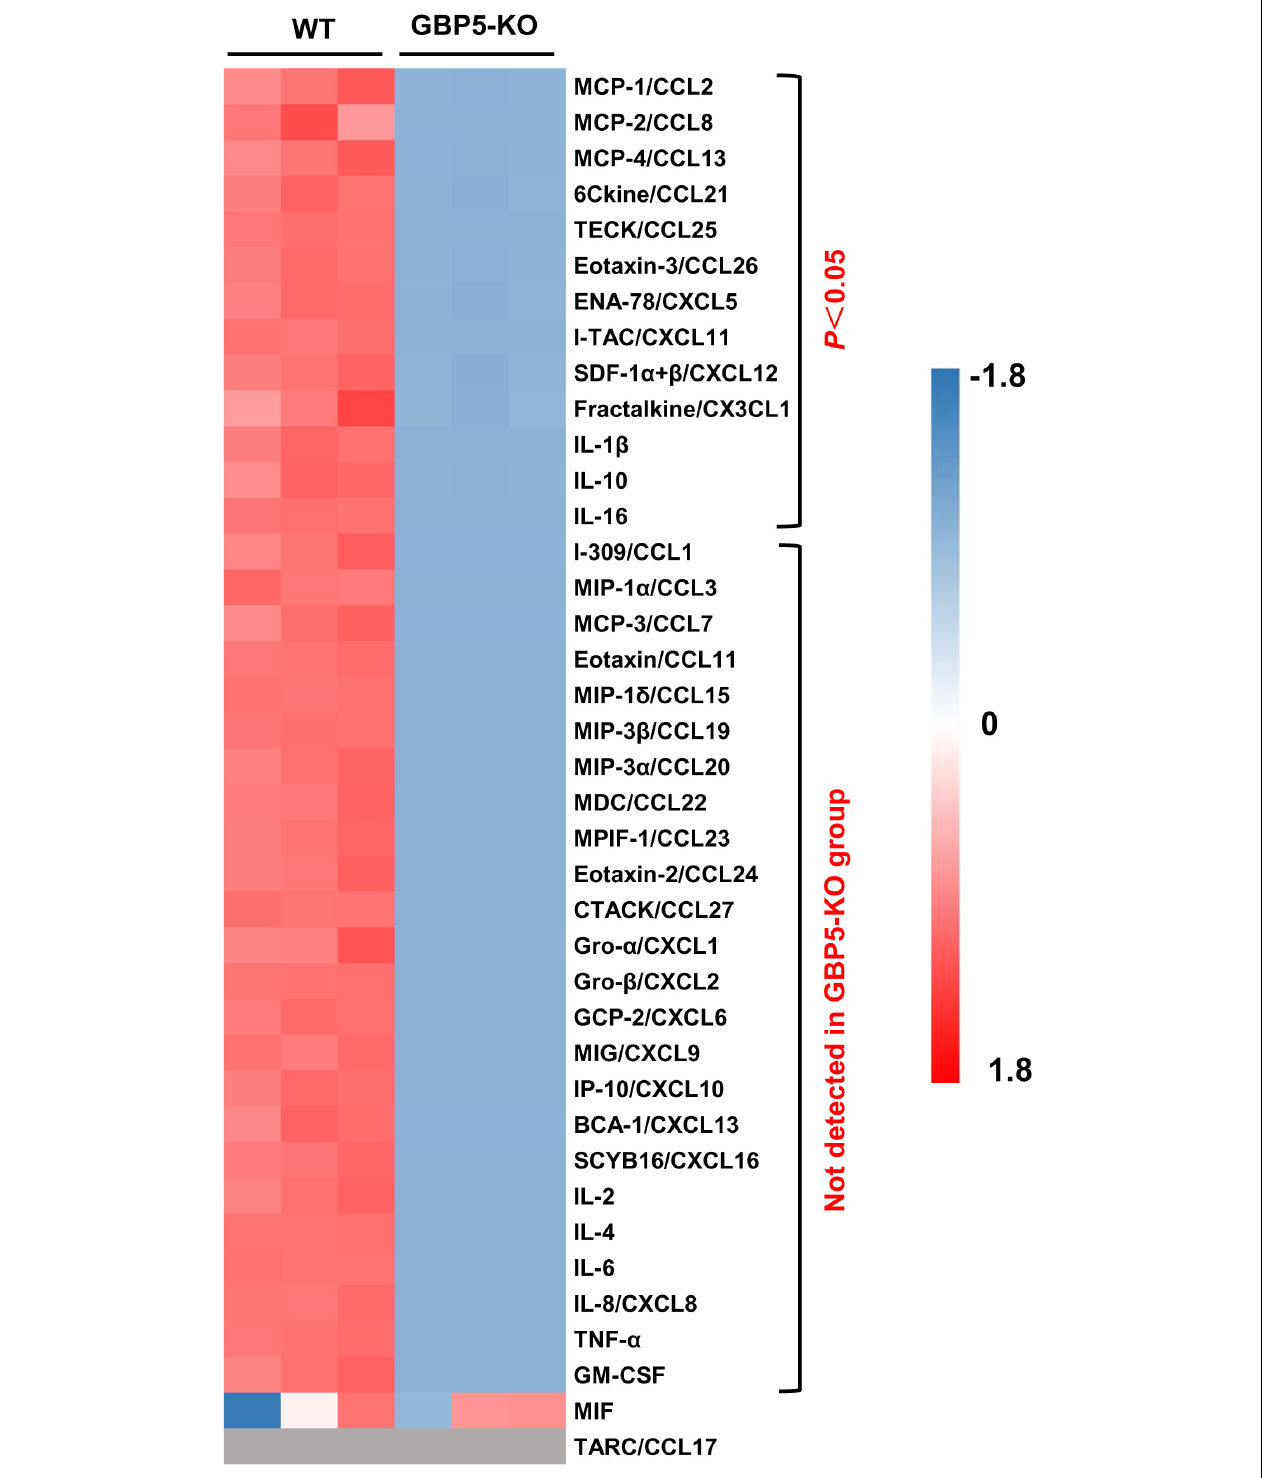
FIGURE 5 | Decreased chemokine and cytokine secretion in GBP5 knockout THP-1 cells. The protein levels of chemokines and cytokines in the cell culture supernatant of wild-type (WT) and GBP5 knockout (KO) THP-1 cells are plotted. Cells were primed with IFN γ and LPS before sample collection. The concentrations of cytokines and chemokines were determined by Luminex liquid suspension chip. Data were normalized as (x-mean)/SD. Gray blocks indicate no detection. P -values were from Student’s t -tests.